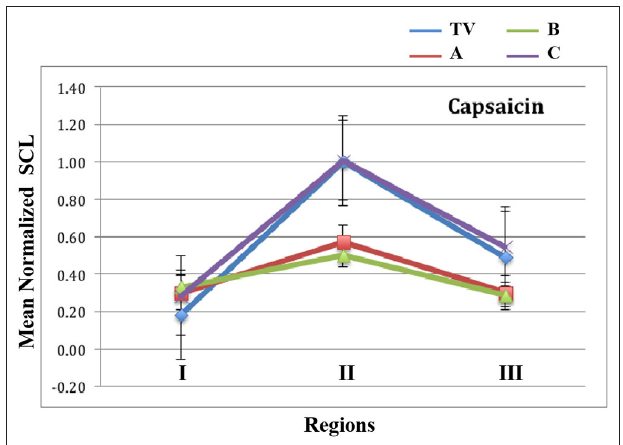
FIGURE 7 | Mean values of normalized SCL within regions I, II, and III for capsaicin. TV = blue, C = Purple, and the analgesics A = red, B = green. Data combine four limb locations from n = 23 participants; bars are stderr.